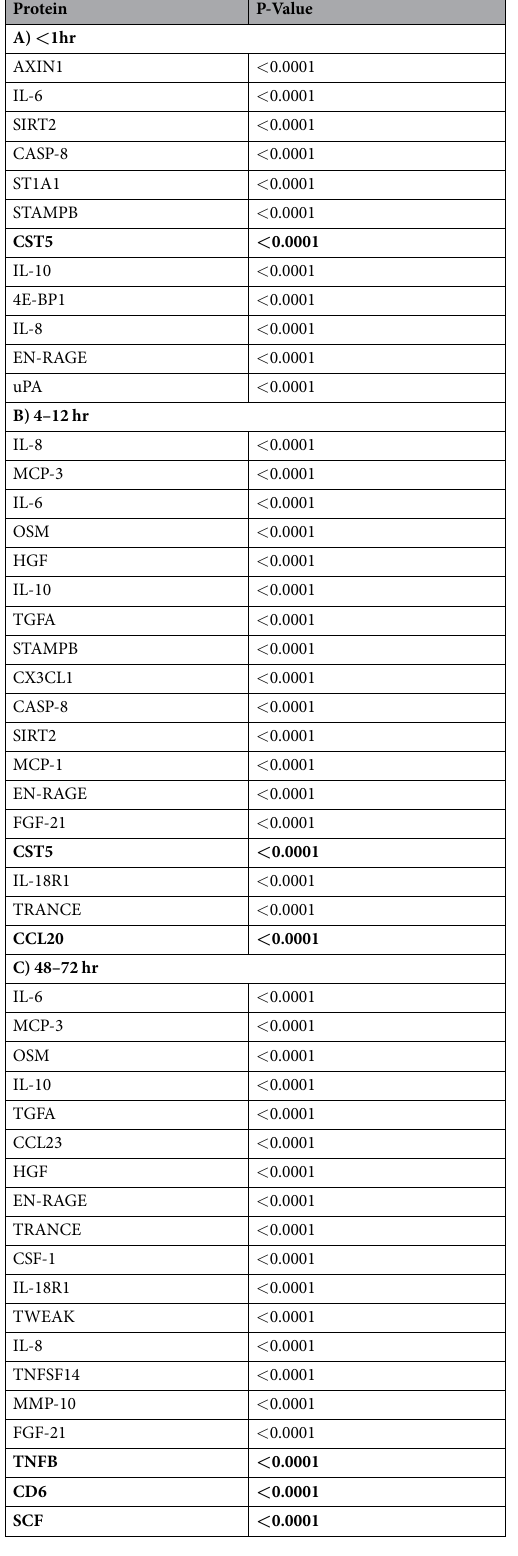
Table 2. Inflammatory proteins which differed between extracranial, mTBI + EC and sTBI + EC across different time points. The inflammatory proteins that differed between HV, EC, mTBI + EC and sTBI + EC at < 1 hr (A), 4–12 hr (B) and 48–72hr (C) are listed. Candidate biomarker proteins are shown in bold . ( Significance = P <